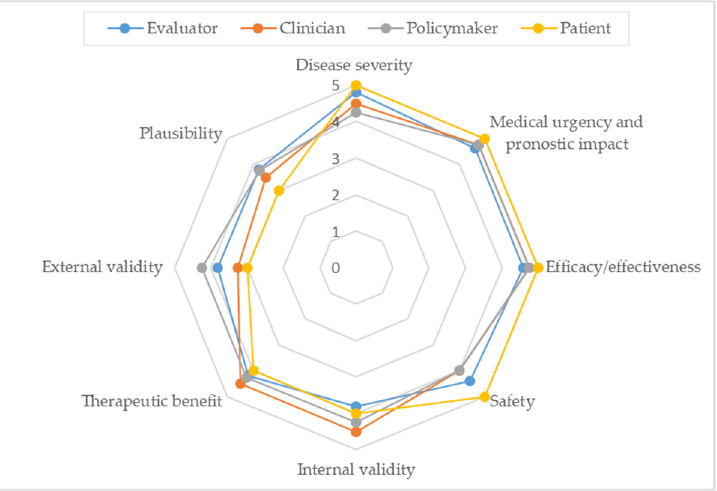
Figure 2. Relative importance according to professional profile.